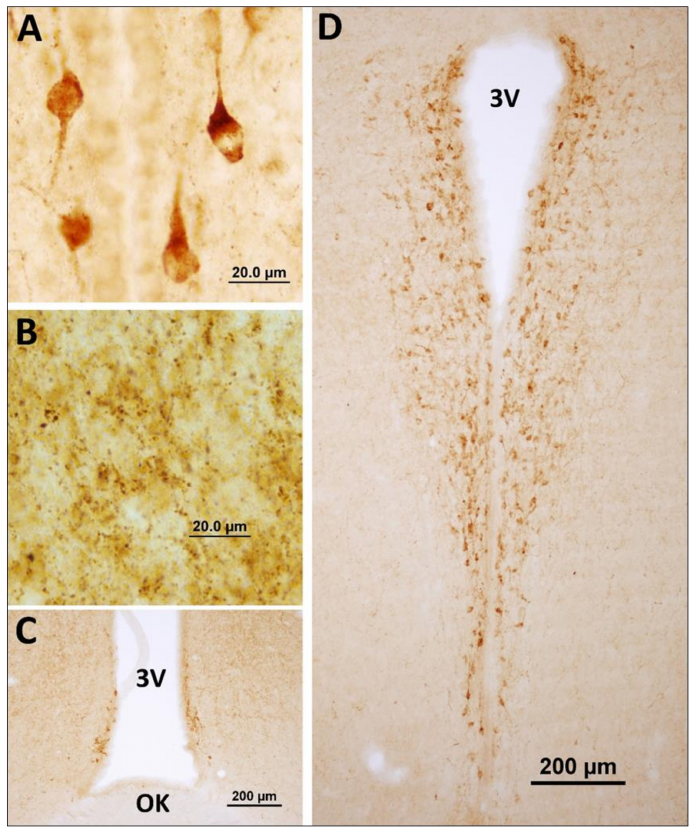
Figure 1. Distribution of neuronostatin neurons in the hypothalamus. ( A , C , D ) Neuronostatin neurons located around the third ventricle in the periventricular nucleus of the anterior hypothalamus. ( B ) Neuronostatin-positive axonal outcomes observed in ventromedial hypothalamic nucleus (VMH). 3V: third ventricle, OK: optic chiasm.